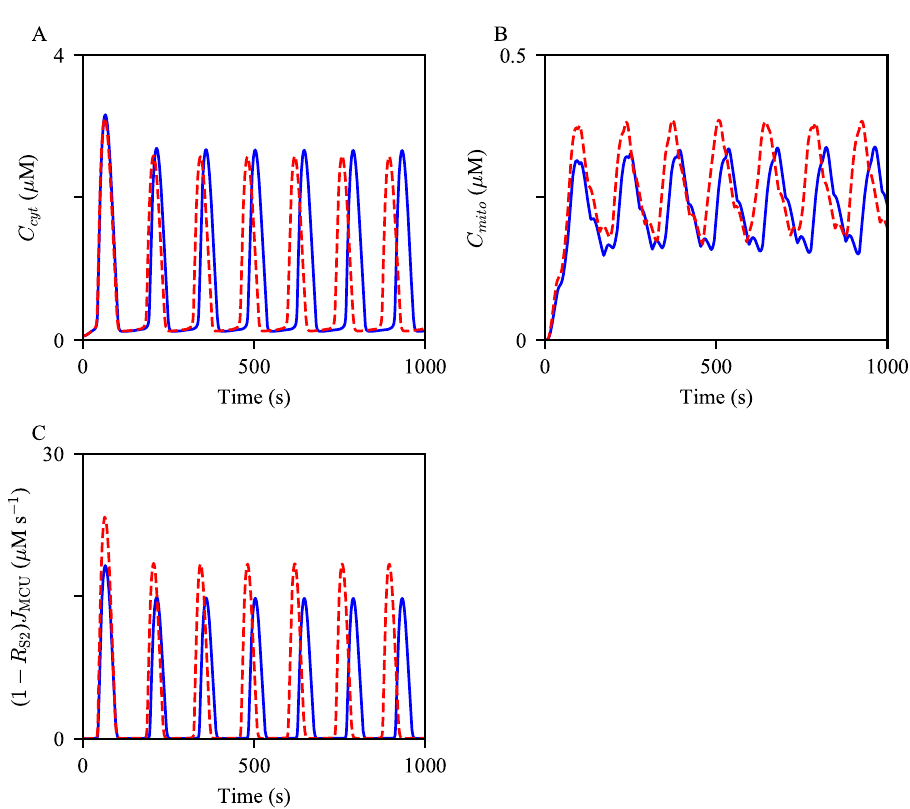
Fig 11. Effects of increased MCU activity on Ca 2+ oscillations. Oscillations of (A) cytosolic, (B) mitochondrial Ca 2+ concentrations generated from the control model, in blue, and with the increased V MCU , in red dashed. The corresponding Ca 2+ fluxes from the cytosol to mitochondria are shown in (C). The model was given continuous stimulation of IP 3 with P s = 0.3 μ